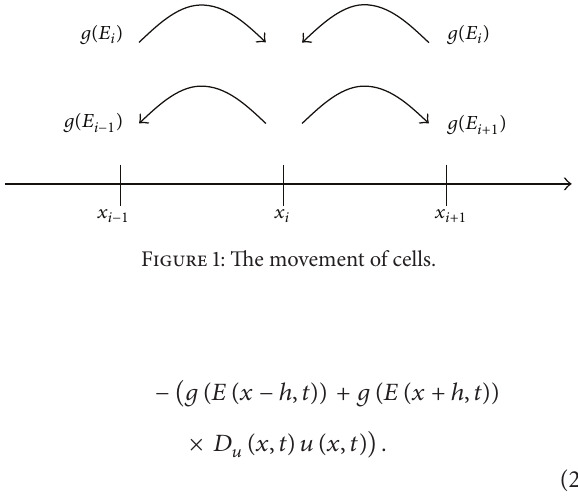
Figure 1: The movement of